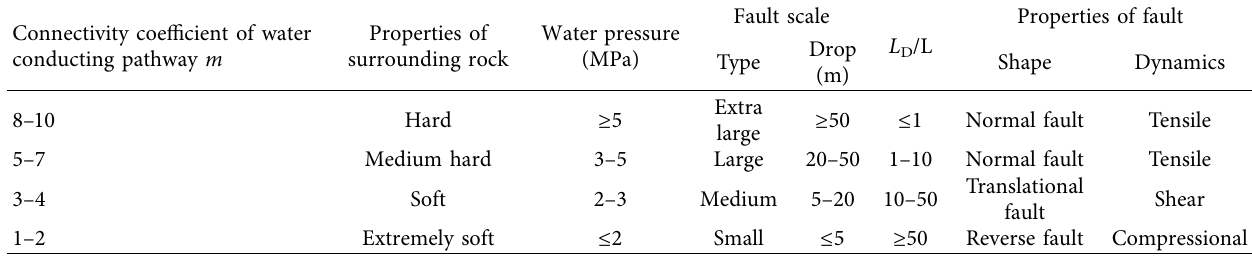
TR represents transport roadway and MR represents material roadway. Table 4: Connectivity coefficients of water conducting pathway of faults in surrounding rock. Connectivity coefficient of water conducting pathway m